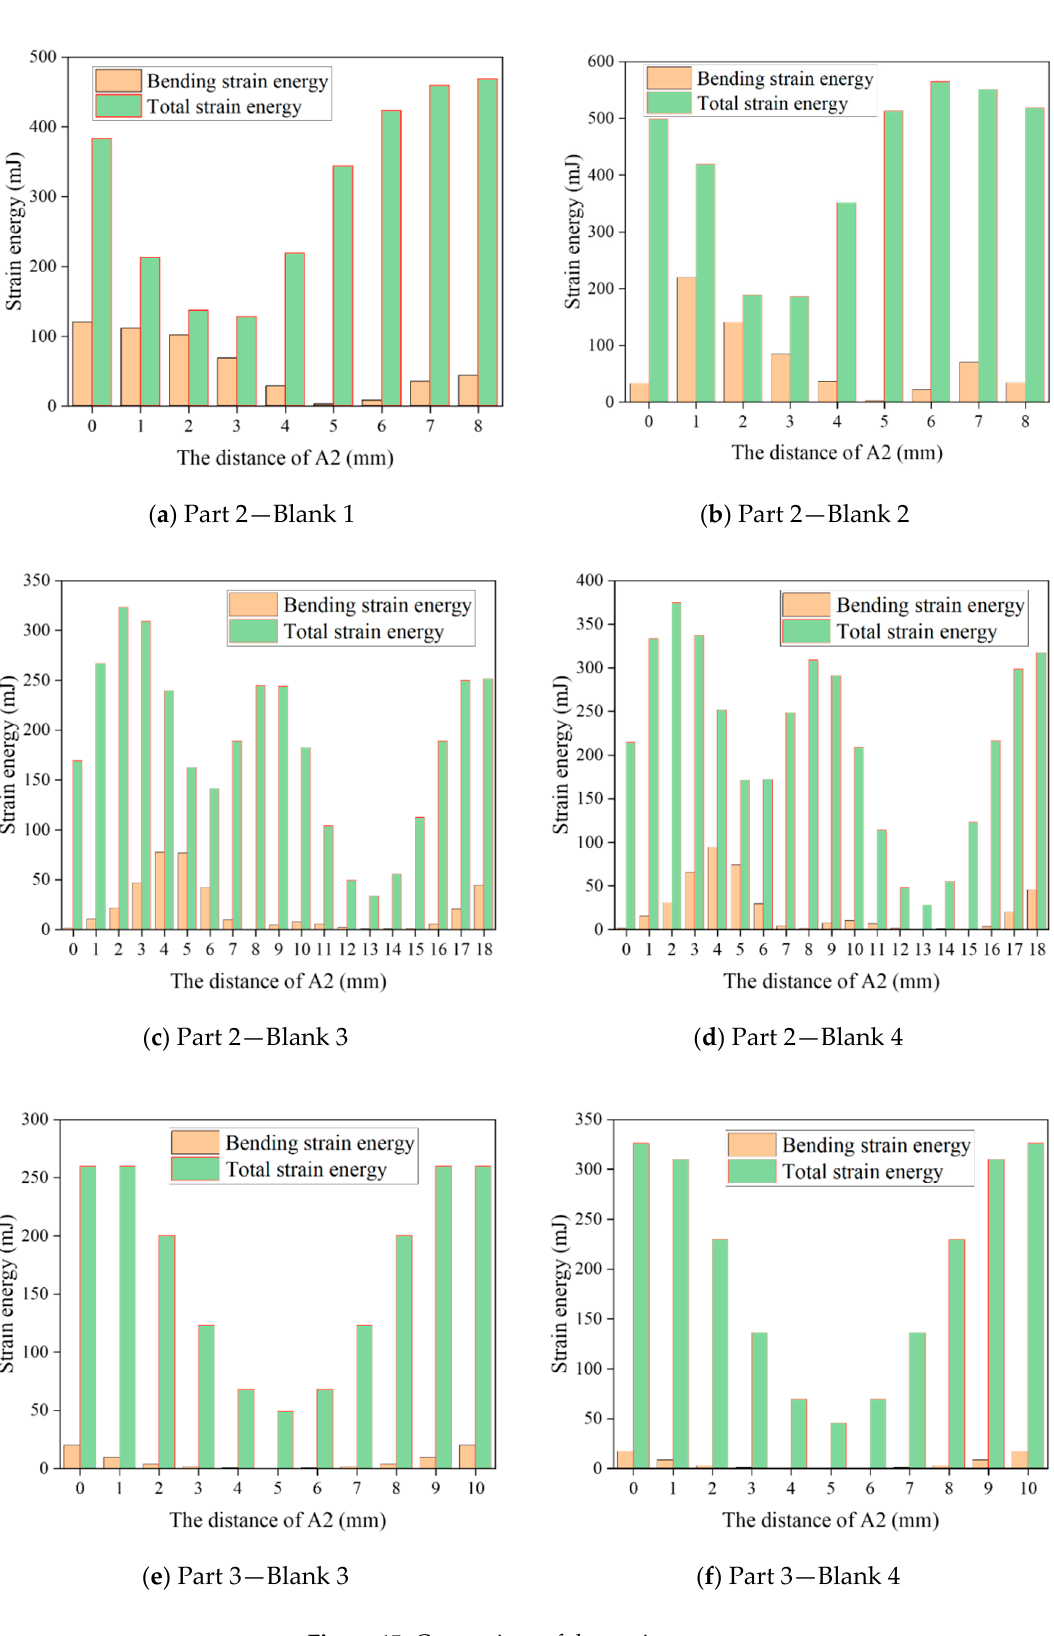
Figure 15. Comparison of the strain energy.